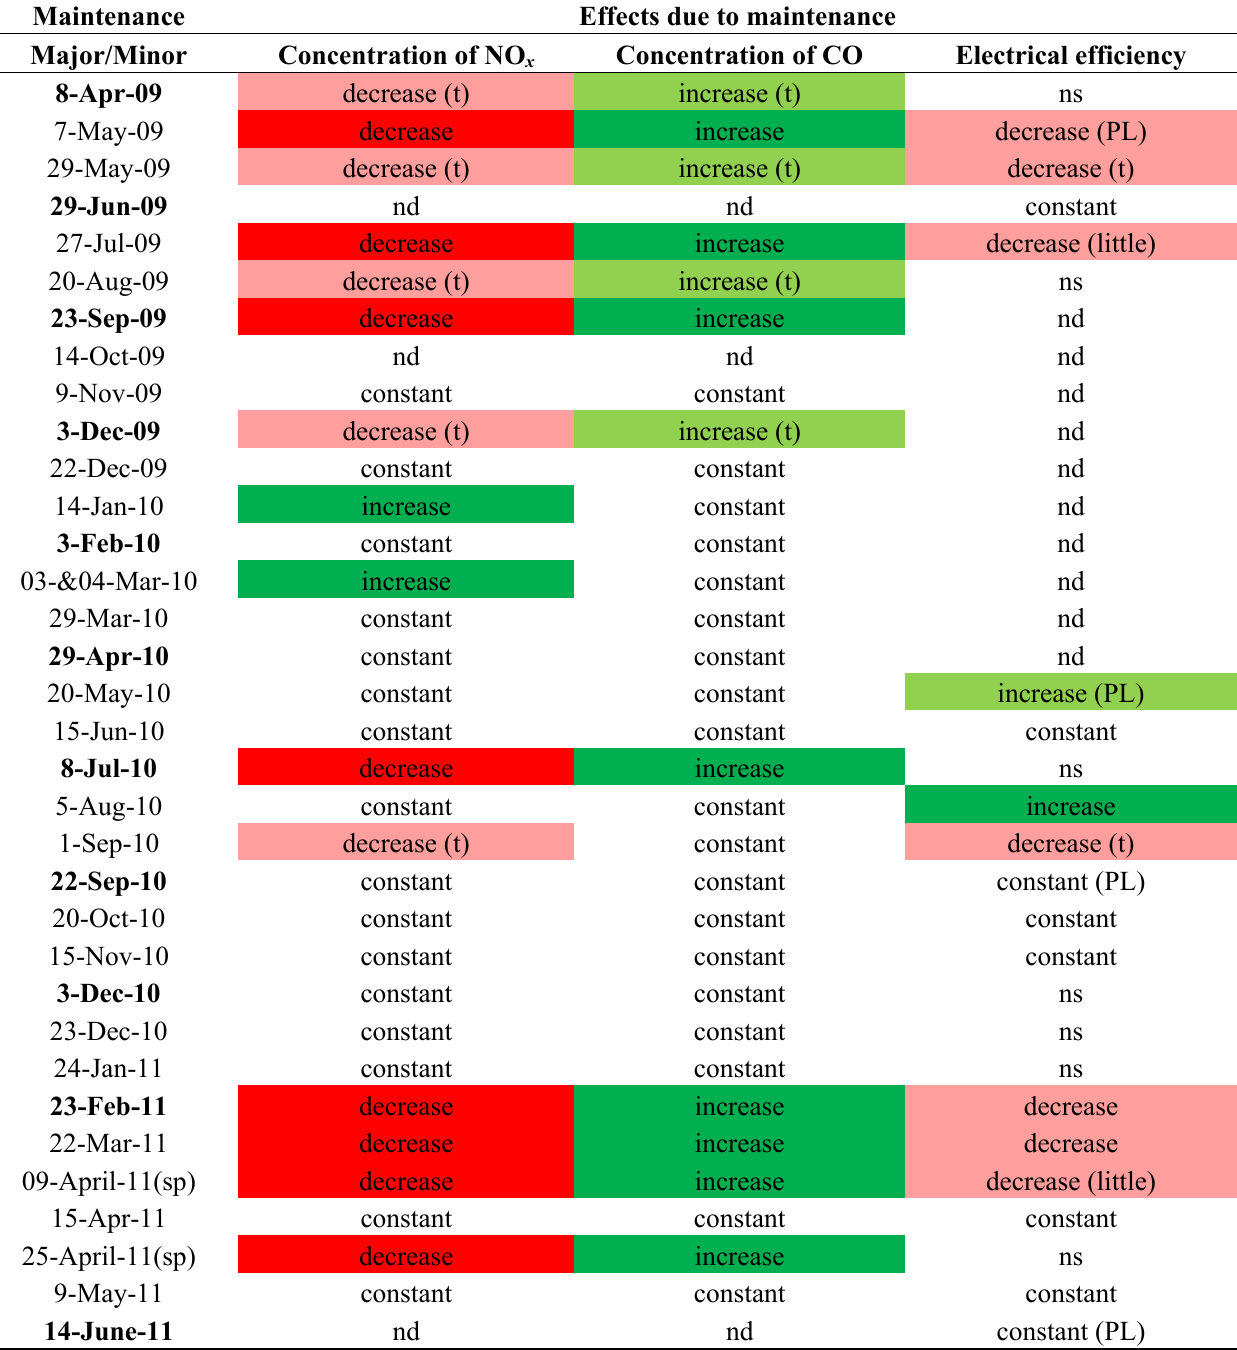
Table 3. Effects of maintenance on electrical efficiency and